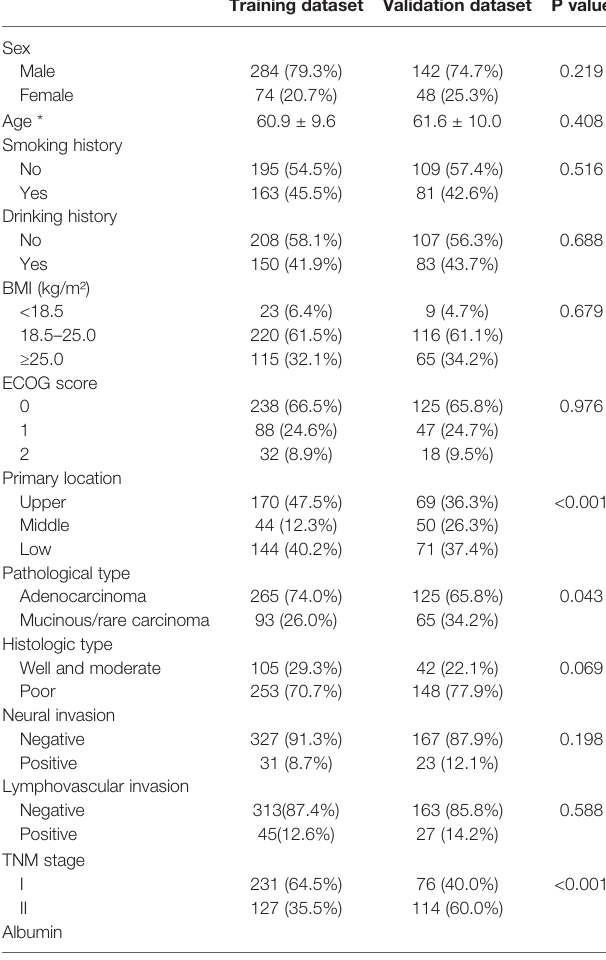
TABLE 6 | Baseline patient clinicopathological characteristics based on different